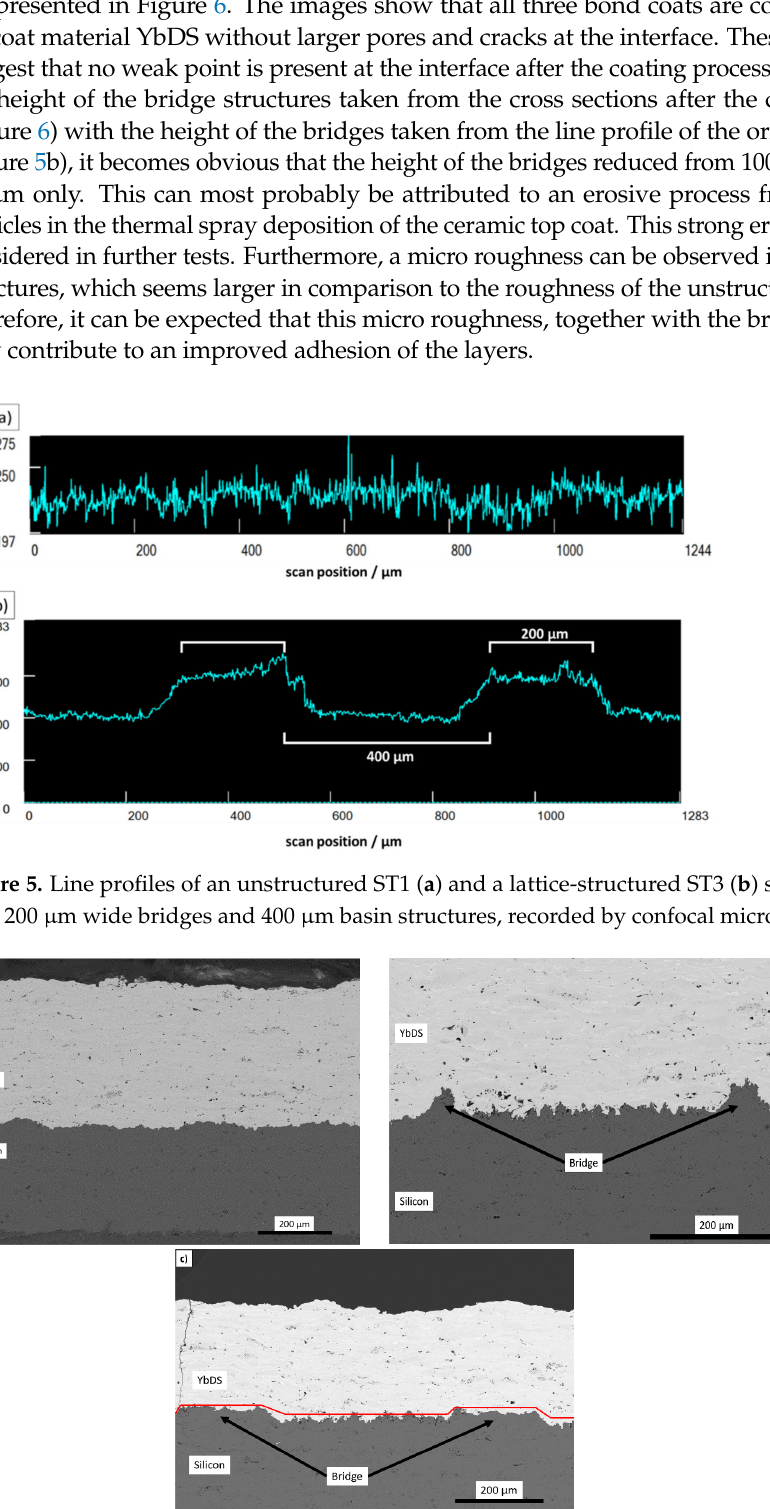
Figure 6. Bond coat/topcoat interface of specimen type 1 ( a ), specimen type 2 ( b ) and specimen type 3 ( c ) before the interface toughness